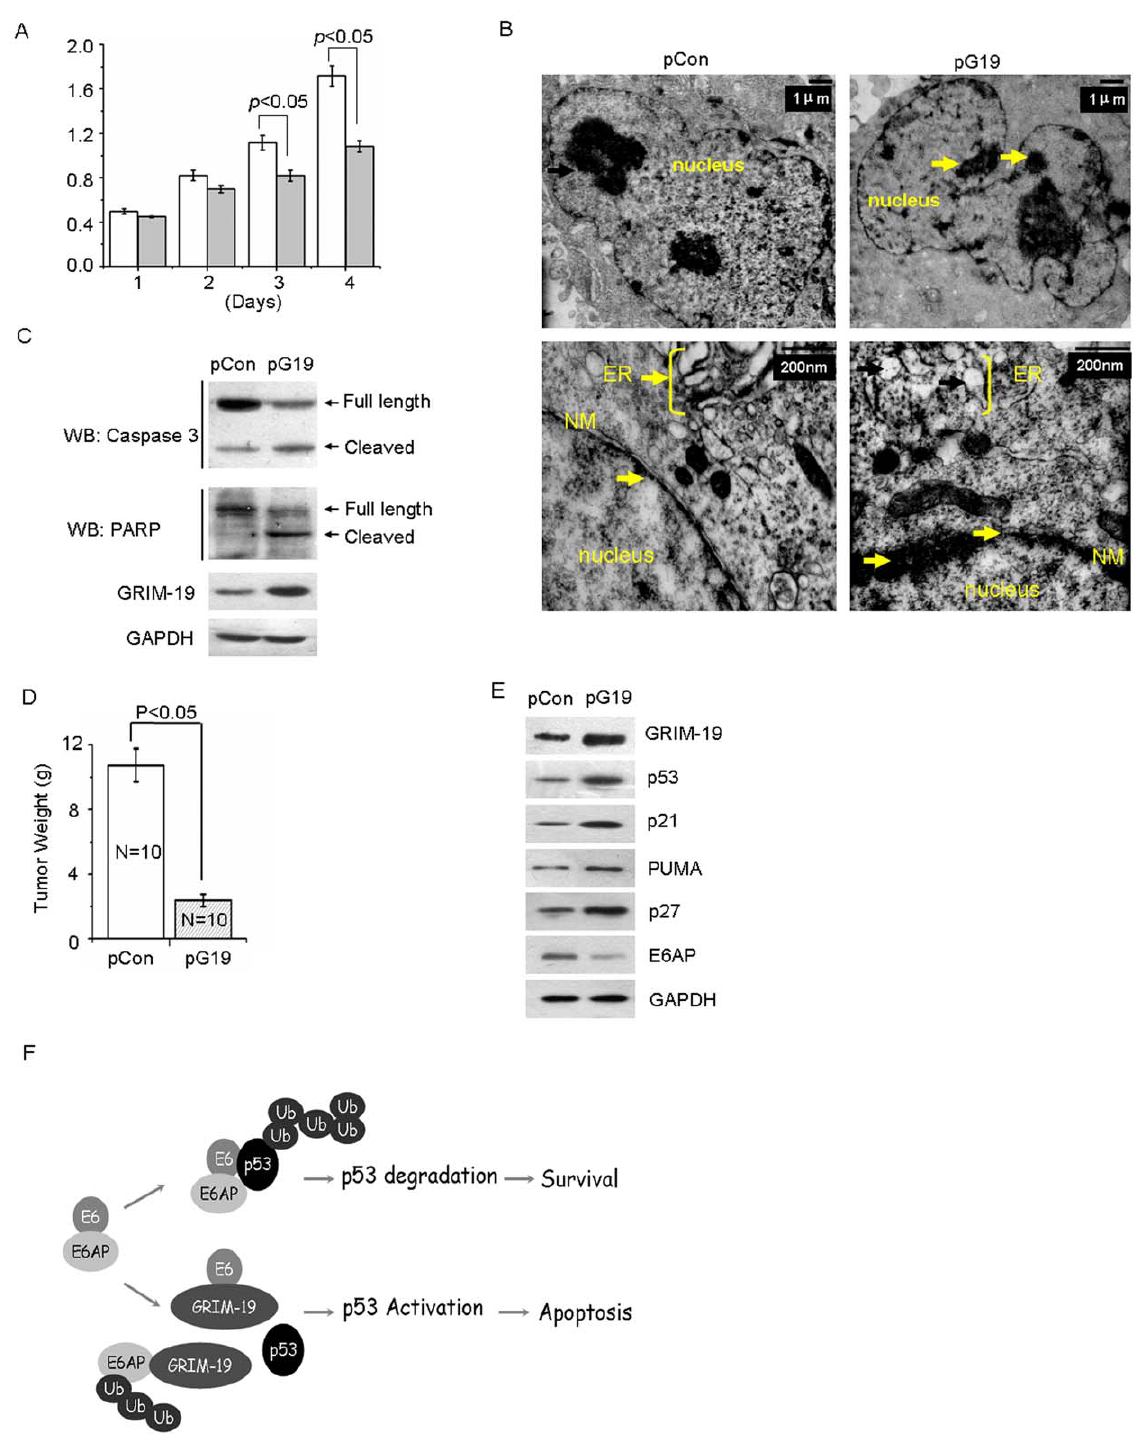
Figure 5. GRIM-19 inhibited cell proliferation and induced apoptosis, and promoted the accumulation of p53 in tumors. ( A ) An MTT assay was performed in the indicated cells. MTT assay was performed as in Materials and Methods. Each data point represents the mean 6 SE of 8 samples. ( B ) The morphological characteristics of HeLa/pCon and HeLa/pG19 cells were examined by transmission electron microscopy. Chromatin condensation, expansion and widened nuclear membrane gaps, vague nuclear membrane structure, fractures of nuclear membrane and endoplasmic reticulum expansion were indicated with arrows. ER, endoplasmic reticulum; NM, nuclear membrane. ( C ) The full length and cleaved form of caspase- 3 and PARP in HeLa/pCon and HeLa/pG19 cells were determined by Western blot analyses. ( D ) HeLa/Con and HeLa/G19 cells were transplanted into 6-week-old female athymic nude mice (10 mice for each cell line) and grown for 6 weeks. Tumors were harvested, and weights were measured. The data present the mean of 10 tumors in each group. ( E ) The expression of GRIM-19, p53, p21, PUMA, p27 and E6AP in the tumors derived from mice as determined by Western blot analyses, and the representative results are presented. ( F ) A model for the collaboration between GRIM-19 and p53. When GRIM-19 is present in high levels, it interacts with the E6/E6AP complex, promotes their ubiquitination, thus, preventing p53 degradation. The loss of GRIM-19 allows the attack of E6/E6AP complex on p53 and its degradation through the proteasome. doi:10.1371/journal.pone.0022065.g005 PLoS ONE |